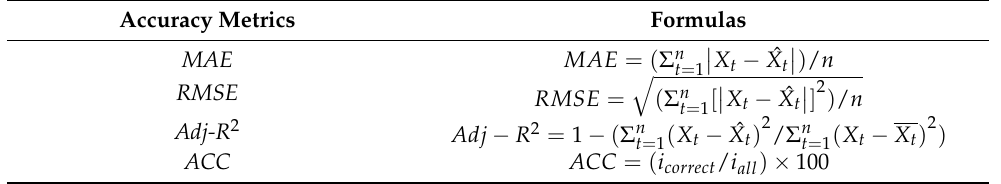
Table 2. Formulas of the accuracy metrics.